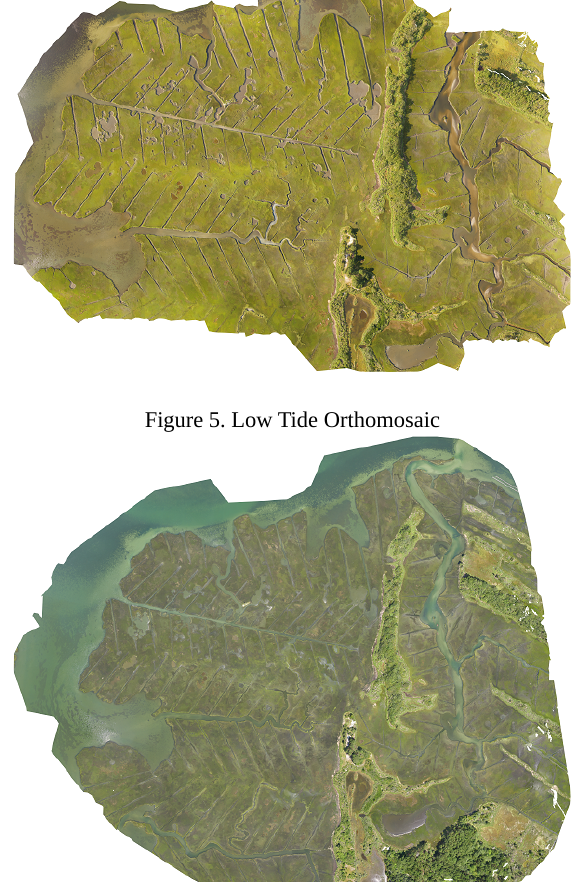
Figure 6. High Tide